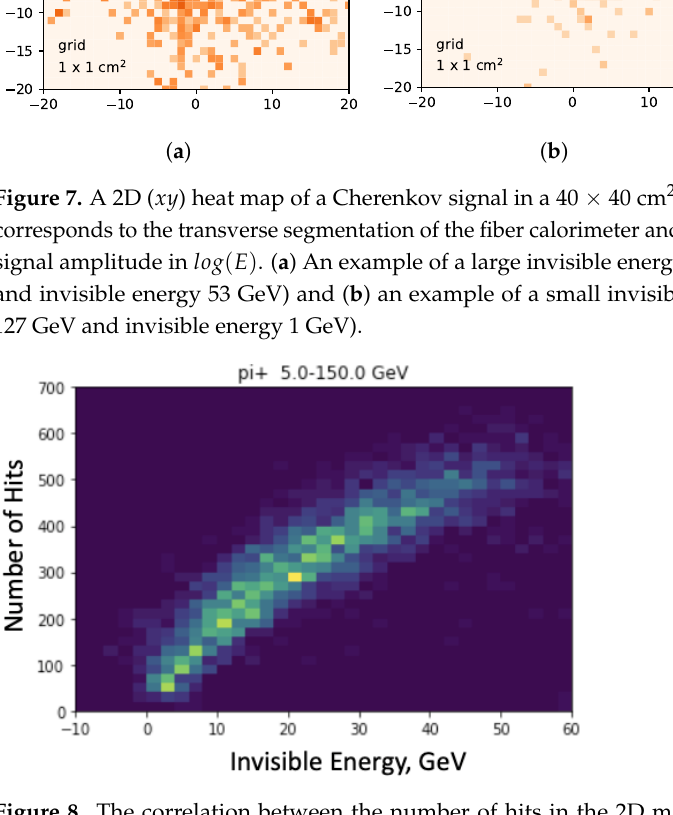
Figure 8. The correlation between the number of hits in the 2D map and the invisible energy is calculated with the energy sum of a Cerenkov